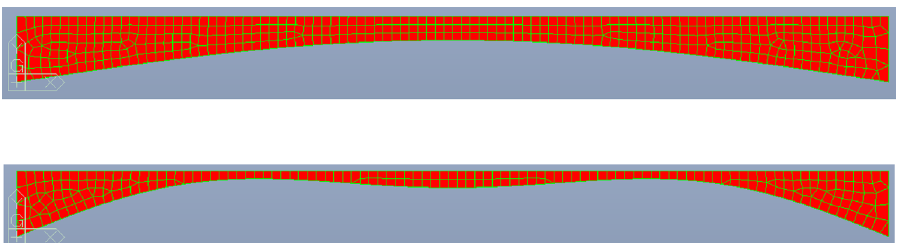
Fig. 9 Overview of the 20 m length beam span Midas models real- ized for the intermediate emptying ratio. The above figure illus- trates model adopting one lobe sine emptying function, whereas